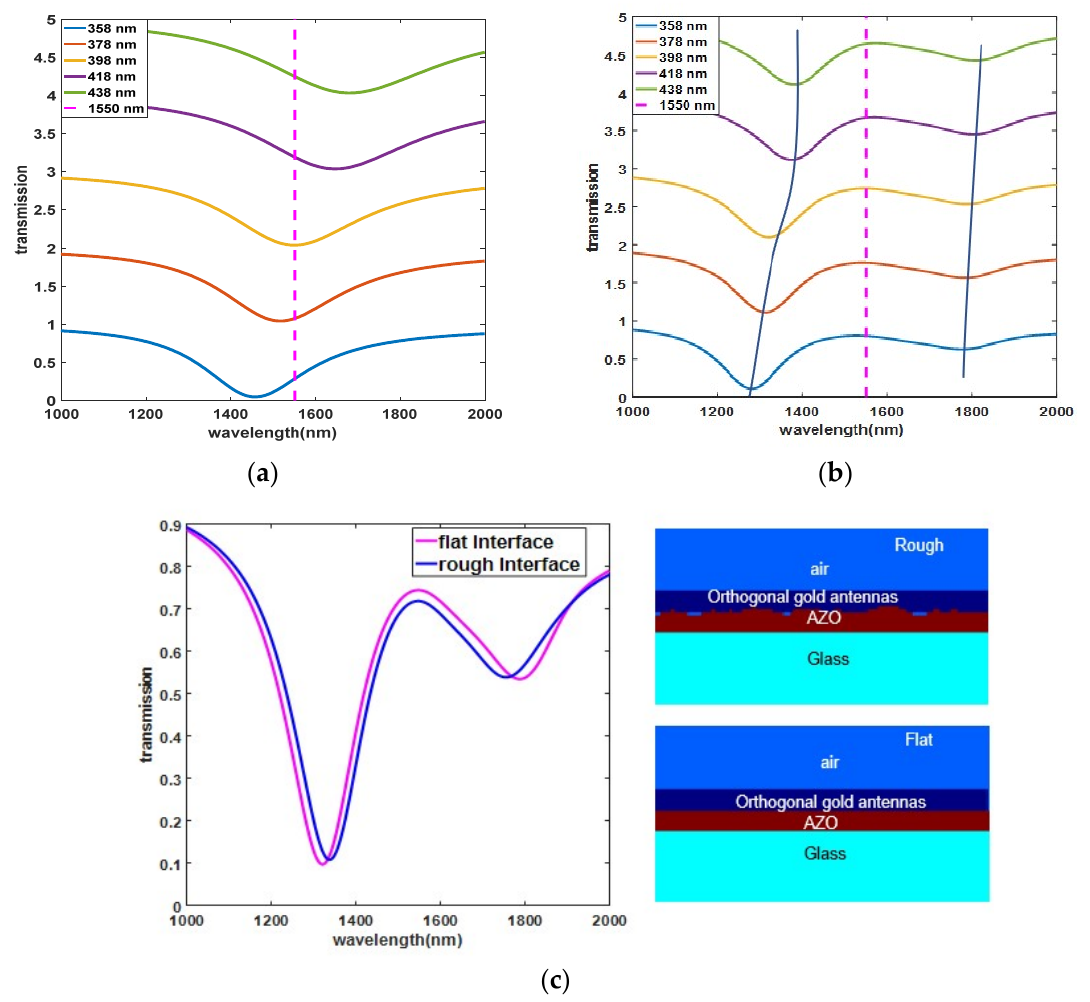
Figure 3. Transmission spectra of x and y polarization. ( a ) Without AZO film; ( b ) With AZO film; ( c ) Transmission spectra for flat interface and rough interface, right-side inset (refractive index monitor views from Lumerical)